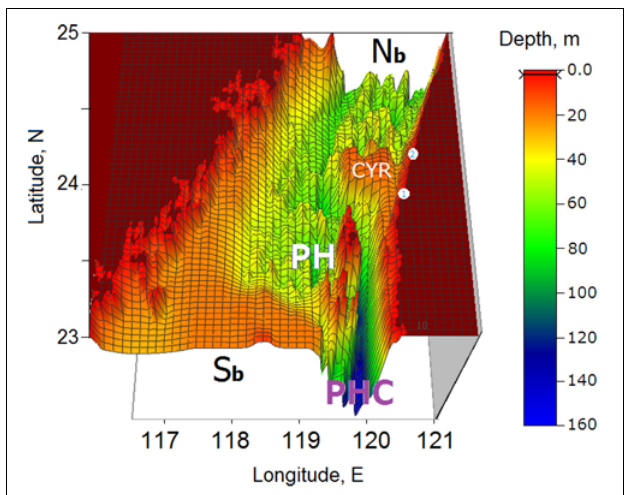
FIGURE 2 | The 3-D model domain with 1 nautical min grid, showing the model’s horizontal resolution with numerous islands, channels, and complex bottom topography features. The x -axis denotes East-West direction; the y -axis denotes North-South direction. CYR, PH, PHC, and points 1 and 2 are defined in Figure 1 . S b and N b represent the southern and northern open boundaries, respectively (modified from Korotenko et al., 2014).